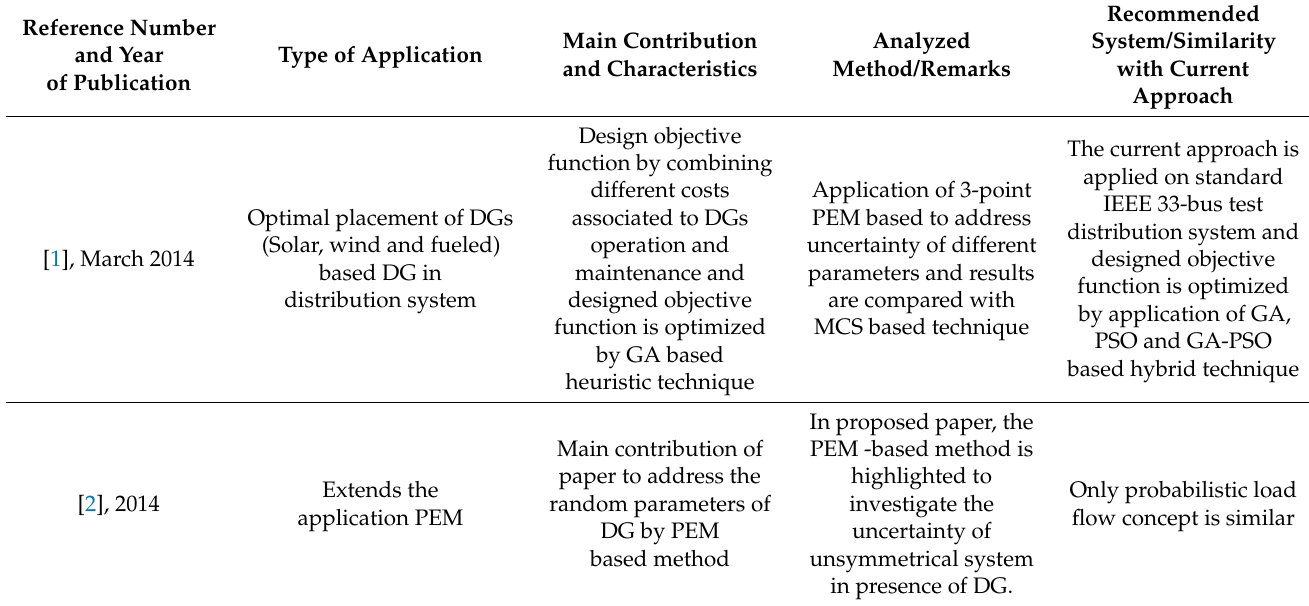
Table 1. Brief detail of extensive literature